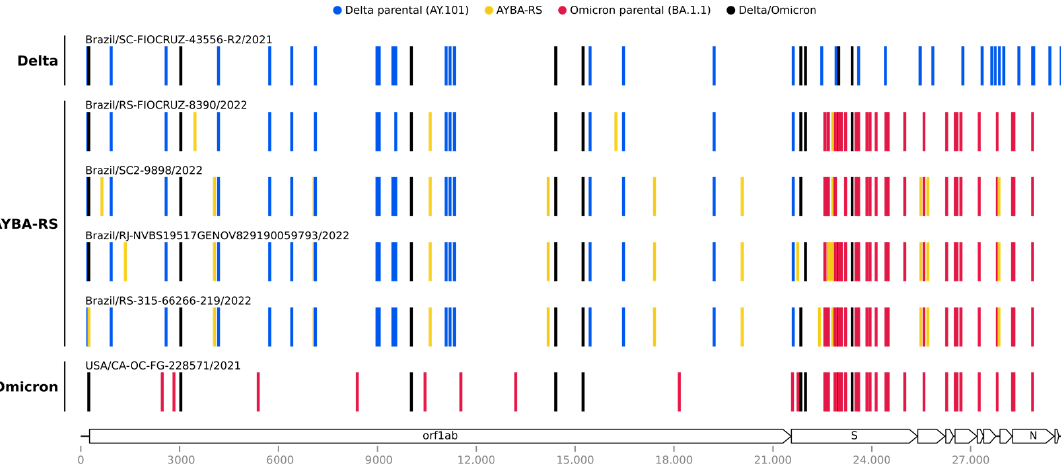
Figure 1. Mutation profiles of the AYBA-RS and the Delta and Omicron variants. The AYBA-RS recombinant presents a similar mutational pattern among the four Brazilian samples, where the first ~22 kb (5’ segment) resembles the Delta variant, and the last ~8 kb (3 ′ segment) the Omicron variant. Vertical colored lines represent nucleotide substitutions, with Wuhan/2019 as the reference. The legend depicts the characteristic mutations of each parental sequence and of the recombinants. The SARS-CoV-2 genome map and their respective coordinates are shown at the bottom.